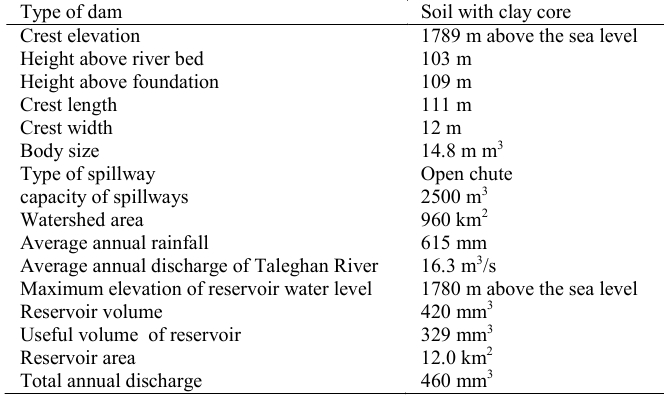
Table 1: Technical specifications of Taleghan Dam reservoir (Farajzadeh et al., 2014) Type of